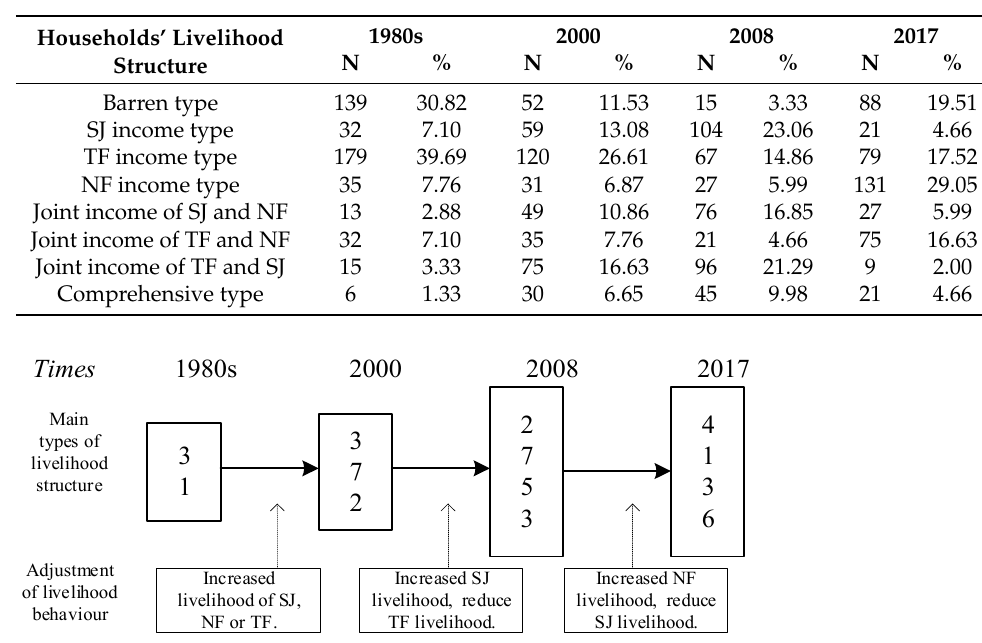
Table 3. A synthesis of livelihoods–land use transitions, key effects, household behavior adapta- tions, and cited interview materials at three stages.